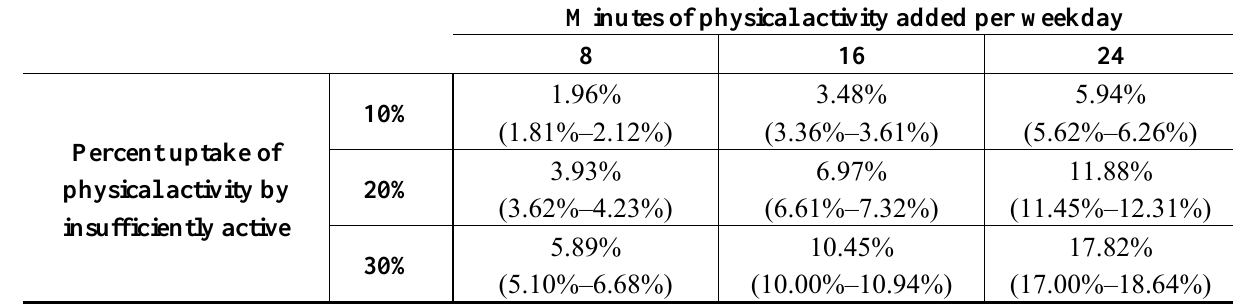
Table 3. Population increase in the proportion of NSW adults who are sufficiently physically active by increases in minutes of physical activity and the percent uptake by those currently inactive.